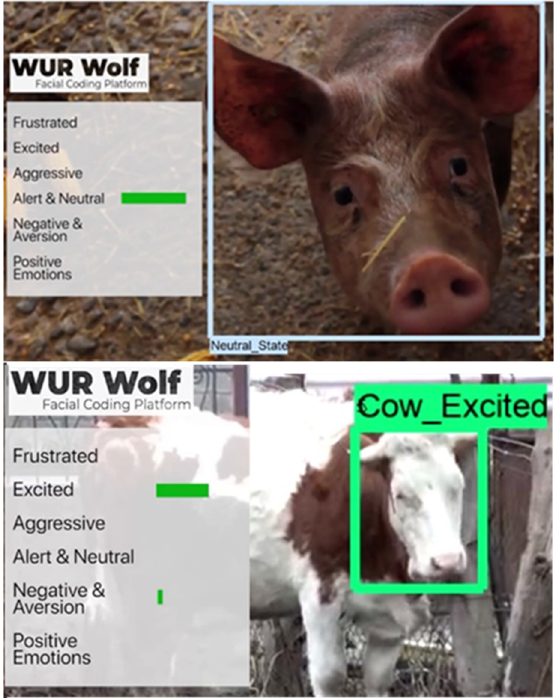
Figure 4. Example emotion detection results from a neutral emotional state pig, and an excited emotional state cow as determined by the WUR Wolf Facial Coding Platform.